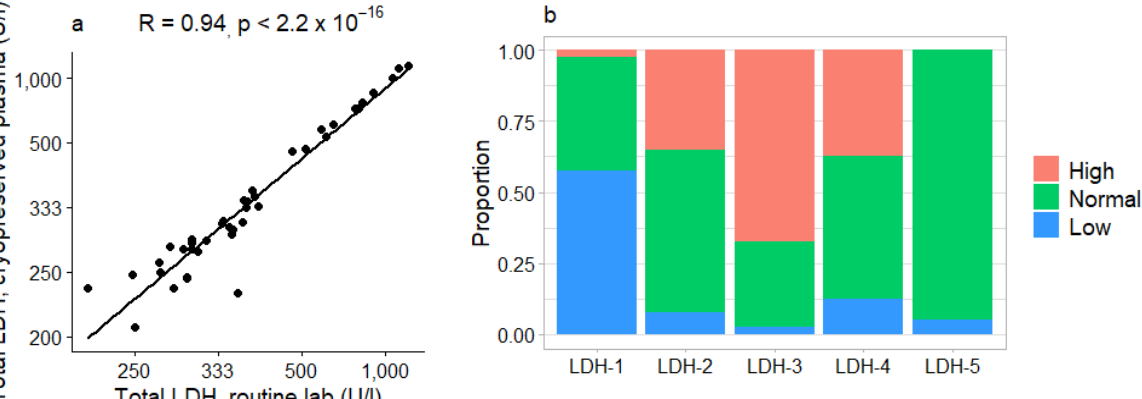
Figure 3. Total LDH levels and LDH isotypes at baseline. ( a ) Correlation between total LDH levels as assessed by routine laboratory assessment and total LDH levels in cryopreserved LDH levels. ( b ) Isotype distribution at baseline. Reference values are 16.1–31.5% for LDH-1, 29.2–41.6% for LDH-2, 17.0–26.2% for LDH-3, 5.9–12.3% for LDH-4 and 3.2–17.3% for LDH-5.